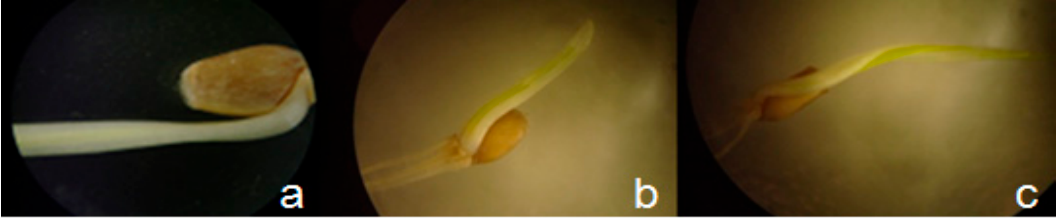
Figure 6. Wheat seedlings from seeds irradiated with UV-B and UV-C (observed in stereoscope at 10X ( a ) and 40X ( b , c )).